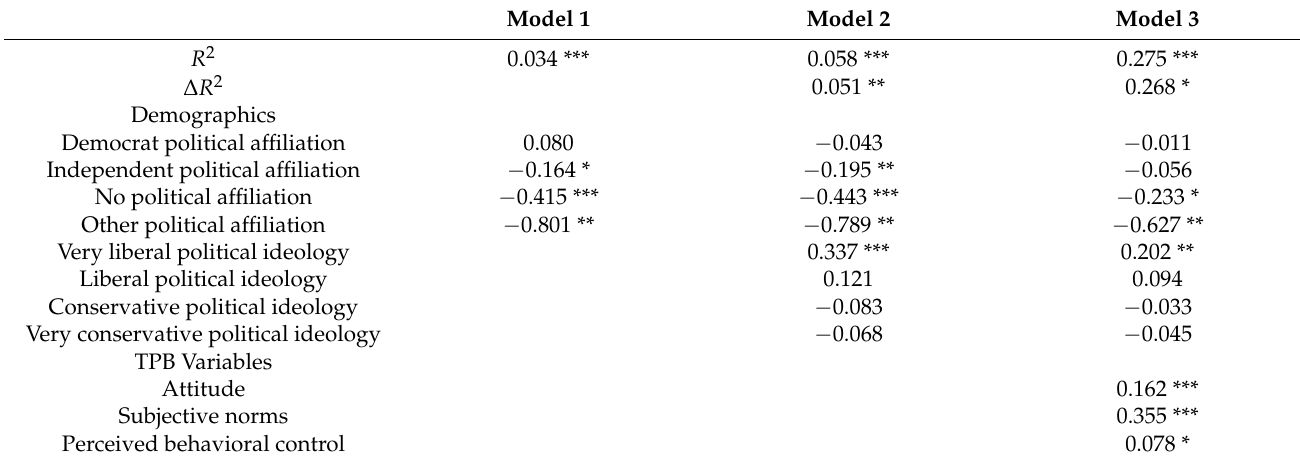
Table 6. Predicting intent to engage in water conservation behaviors using TPB variables and political affiliation and political ideology (N =